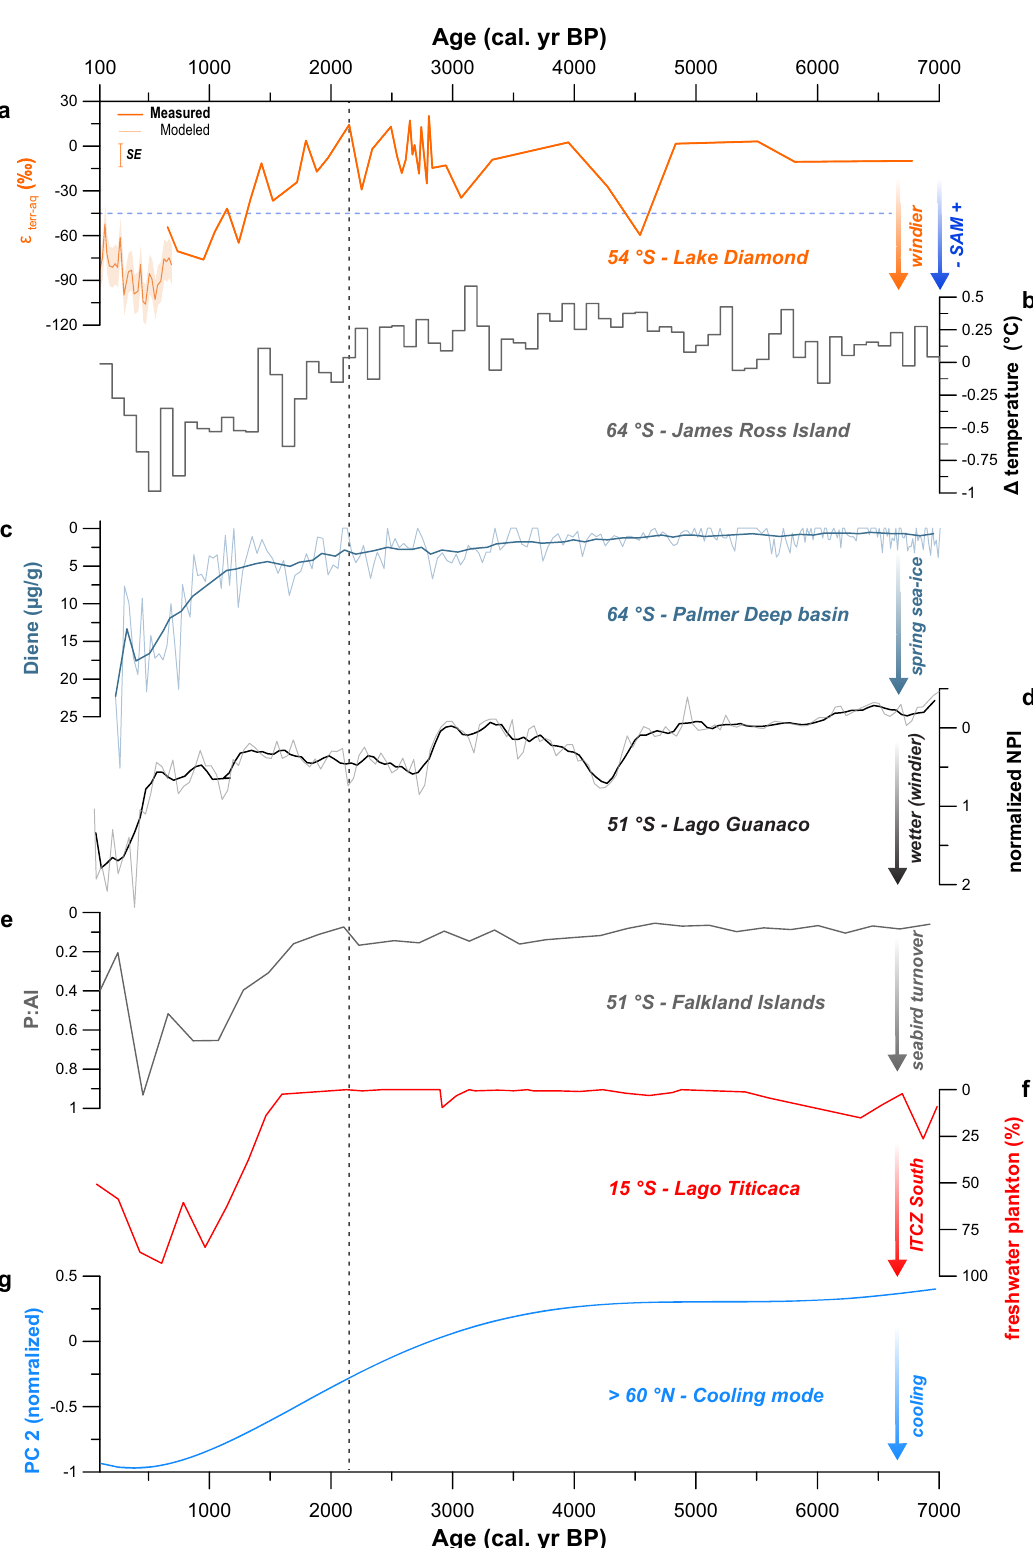
Fig. 9 could have been caused by modes of internal variability. Speci fi cally, the El Niño-southern oscillation or ENSO 14 . El Niño events are associated with negative SAM phases because positive temperature anomalies in the Tropical Paci fi c trigger Rossby wave trains that propagate positive pressure differences poleward 88 . Conversely, La Niña events coincide with positive SAM phases as